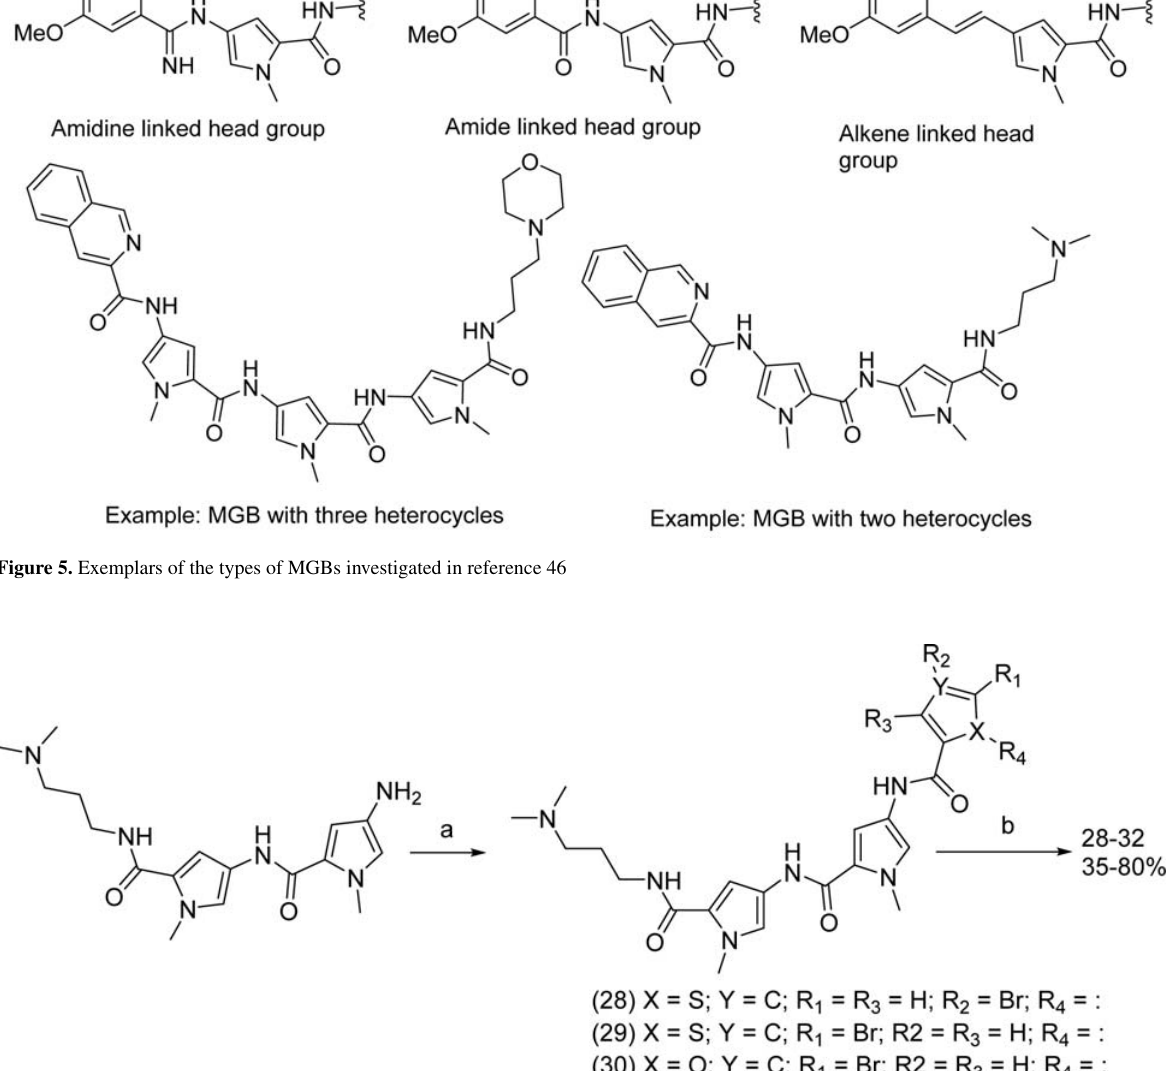
) , K CO , microwave 3 4 2 3